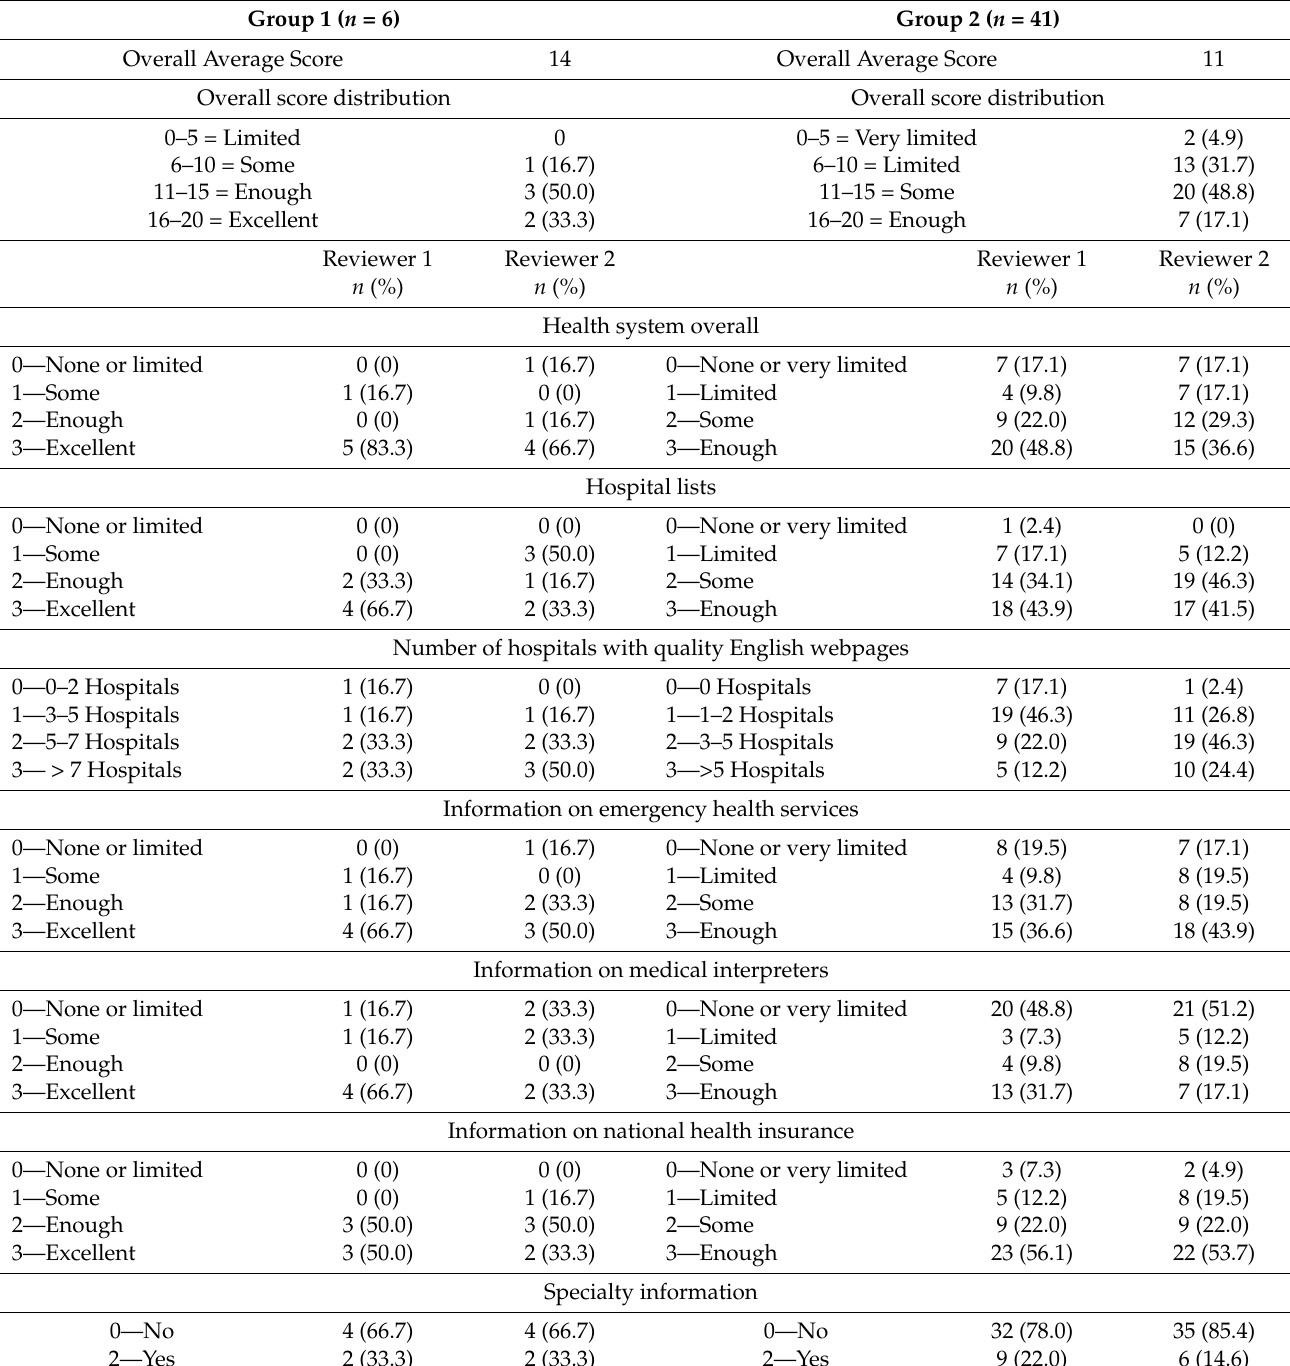
Table 2. A summary MHCIE score table for